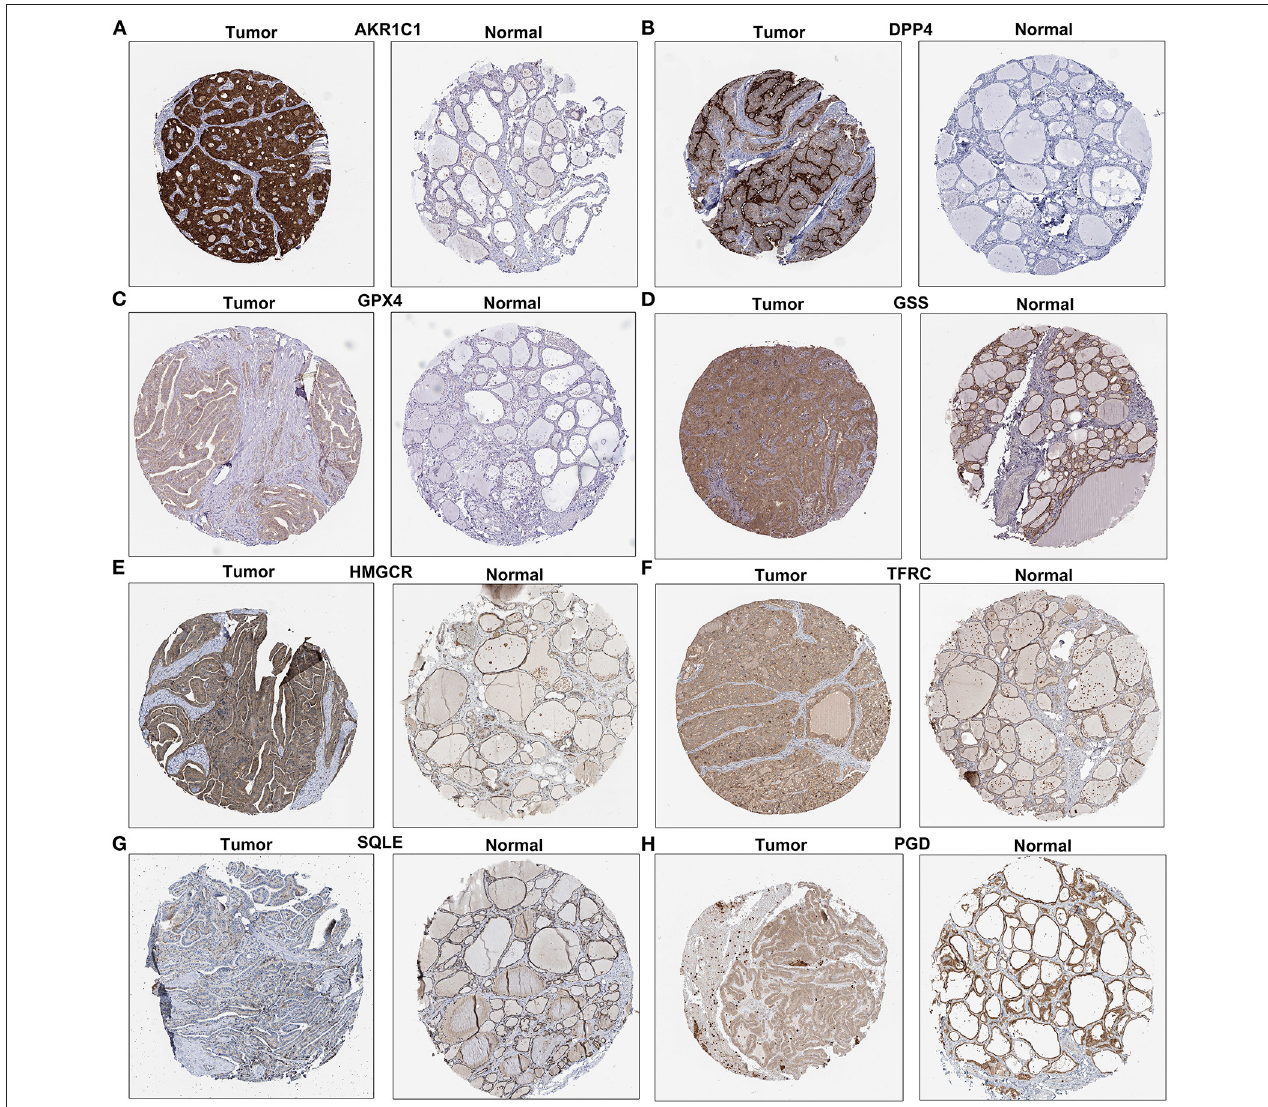
FIGURE 7 | Immunohistochemistry showing the expression of (A) AKR1C1, (B) DPP4, (C) GPX4, (D) GSS, (E) HMGCR, (F) TFRC, (G) SQLE, and (H) PGD in thyroid cancer and normal tissues. Scale bar: 200 µ